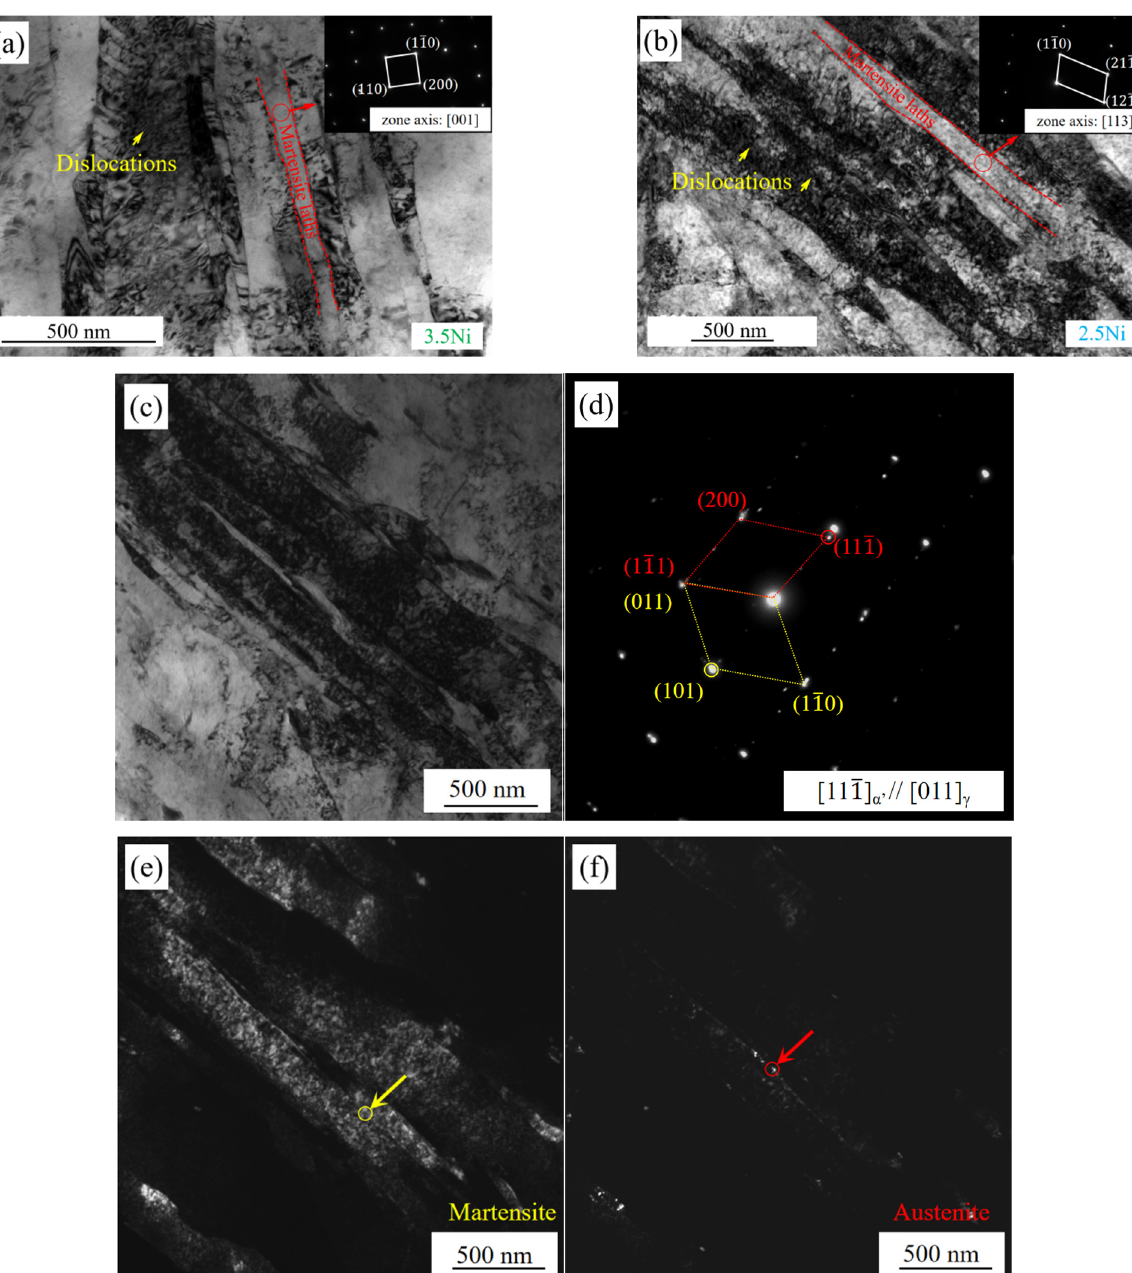
Figure 5. ( a , b ) TEM micrographs of the typical martensite microstructure of the two steels. ( c – f ) TEM micrographs of martensite and austenite microstructure in sample T500 of 3.5 Ni steel; ( c ) bright-field image; ( d ) SAED pattern; ( e ) dark field image of martensite with (101) α ’ reflection; ( f ) dark field image of austenite with (11 1(cid:3364) ) γ ’ reflection.